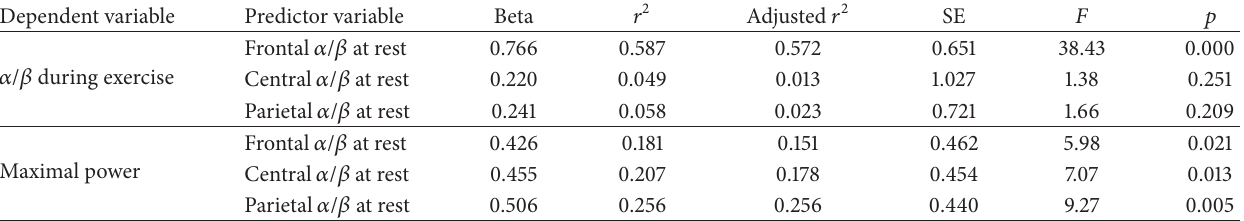
Table 3: Prediction of alpha/beta ratio during exercise and maximal power by resting alpha/beta ratio in cyclists ( 𝑛 = 29 ). Dependent